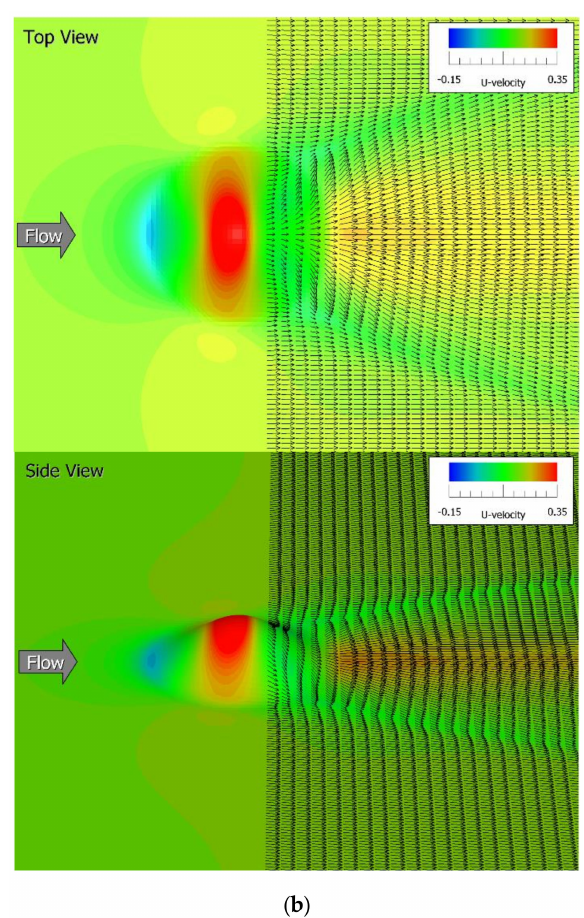
Figure 14. Comparison of surface flow patterns for a time-averaged flow field in the steep hill scenario. ( a ) Ri = 0.0 (neutral flow) ( top view ) Ri = 0.0 (neutral flow) ( side view ); ( b ) Ri = 1.0 (stable stratified flow) ( top view ) Ri = 1.0 (stable stratified flow) ( side view